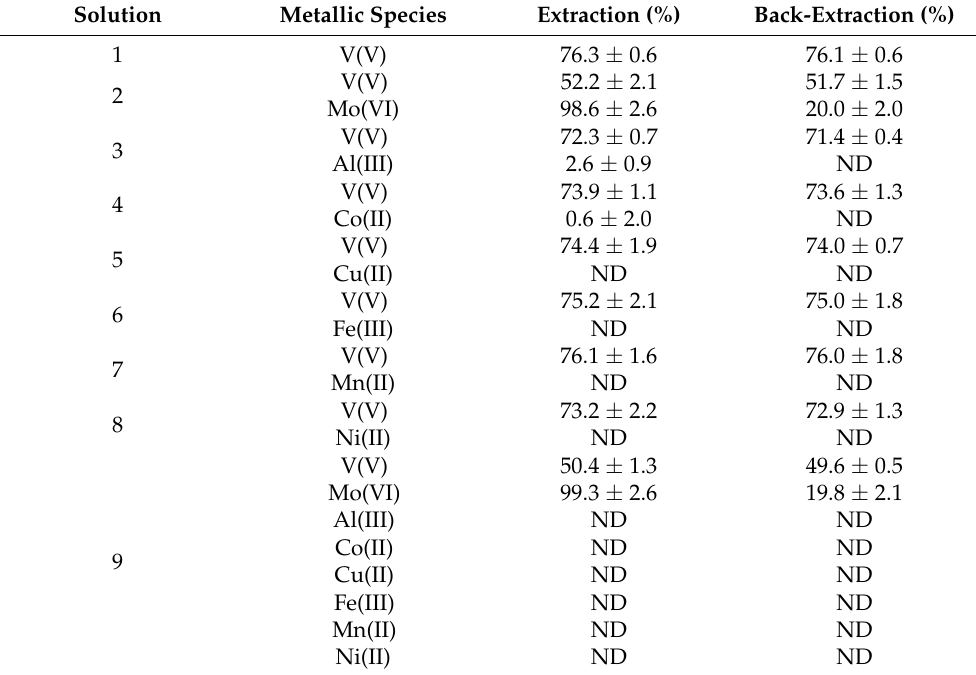
Table 2. Extraction and back-extraction percentages of V(V) from its solutions containing other metallic species a,b